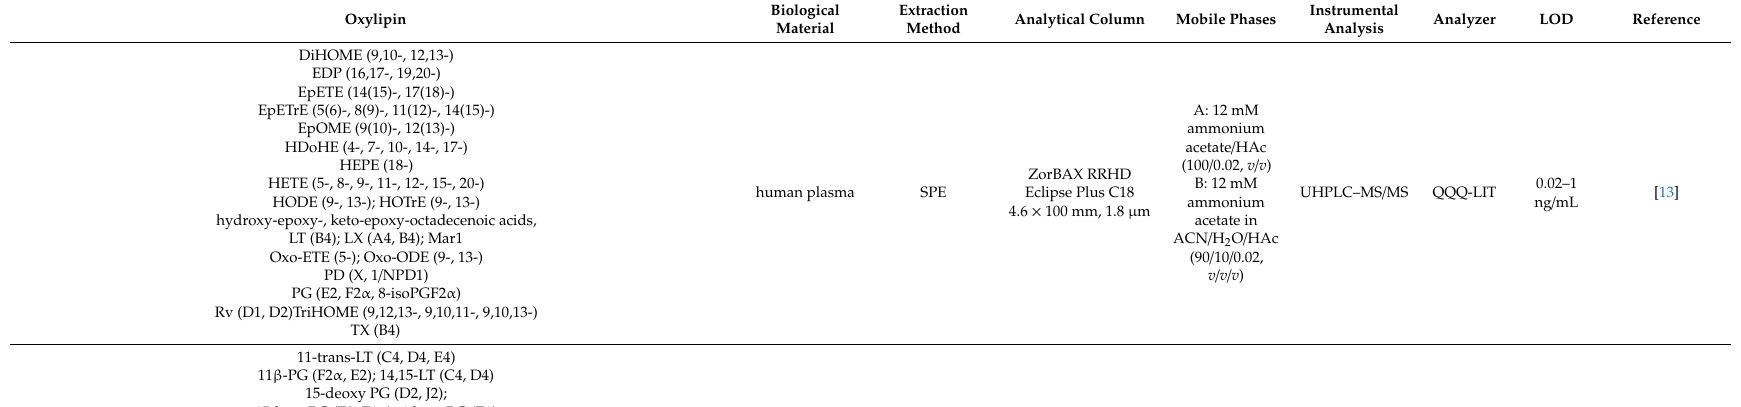
Table 2. Cont. Oxylipin Biological Material Extraction Method Analytical Column Mobile Phases Instrumental Analysis